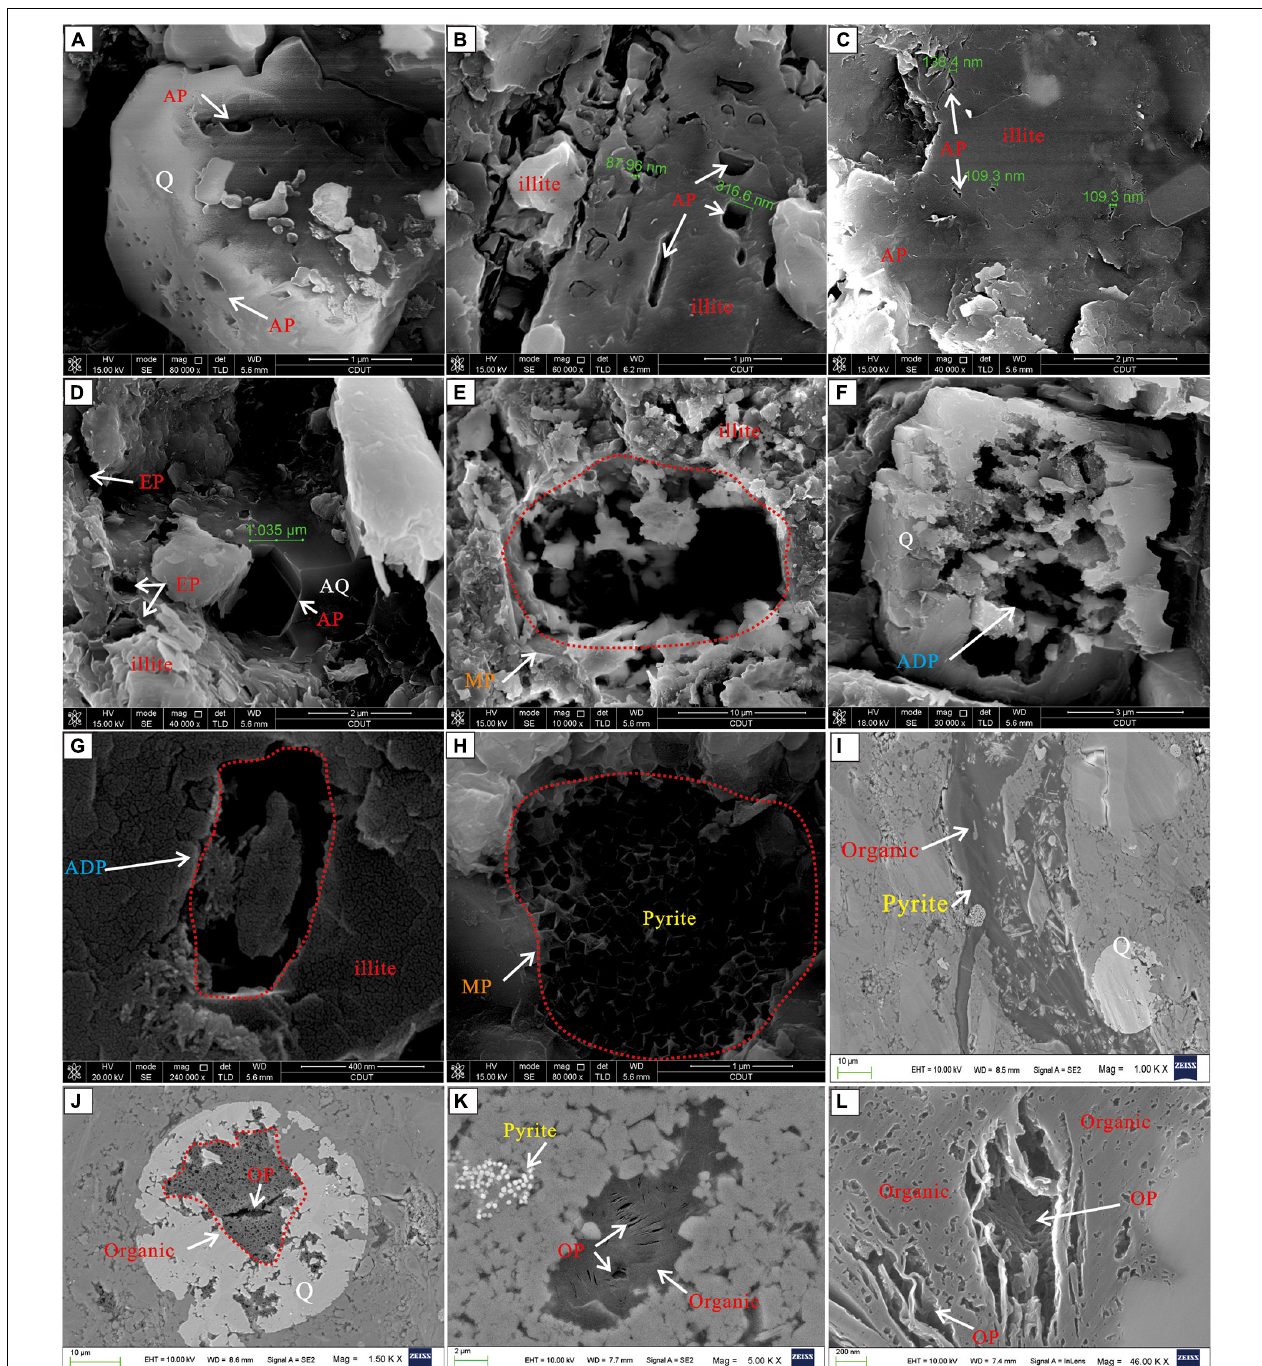
FIGURE 4 | Types and characteristics of pore spaces of the Longmaxi Formation shale in the Sichuan Basin [scanning electron microscope (SEM) and field emission scanning electron microscope (FESEM)]. (A) An SEM image showing intragranular pores (AP) of authigenic quartz (AQ), the Shizhu section, layer 4. (B) An SEM image showing intragranular pores (AP) of illite, the Xiushan section, layer 5. (C) An SEM image showing intragranular pores (AP) of illite, the Pengshui section, layer 4. (D) An SEM image showing intergranular pores (EP) of illite and intragranular pores (AP) of quartz, the Pengshui section, layer 7. (E) An SEM image showing intragranular dissolved pores (ADP) of quartz, the Xiushan section, layer 3. (F) Intragranular dissolved pores (ADP) of quartz, the Shizhu section, layer 4. (G) An SEM image showing intragranular dissolved pores (ADP), the Qijiang section, layer 7. (H) An SEM image showing molded pores (MP) of strawberry pyrite, the Pengshui section, layer 5. (I) An FESEM image showing organic matter and pyrite, well JY-2, 2,459.34 m. (J) An FESEM image showing organic micropore (OP), well JY-2, 2,459.36 m. (K) An FESEM image showing organic micropores (OPs) and pyrite, well W-201, 2,678.61 m. (L) An FESEM image showing organic micropores (OPs), well N-203, 2,325.64